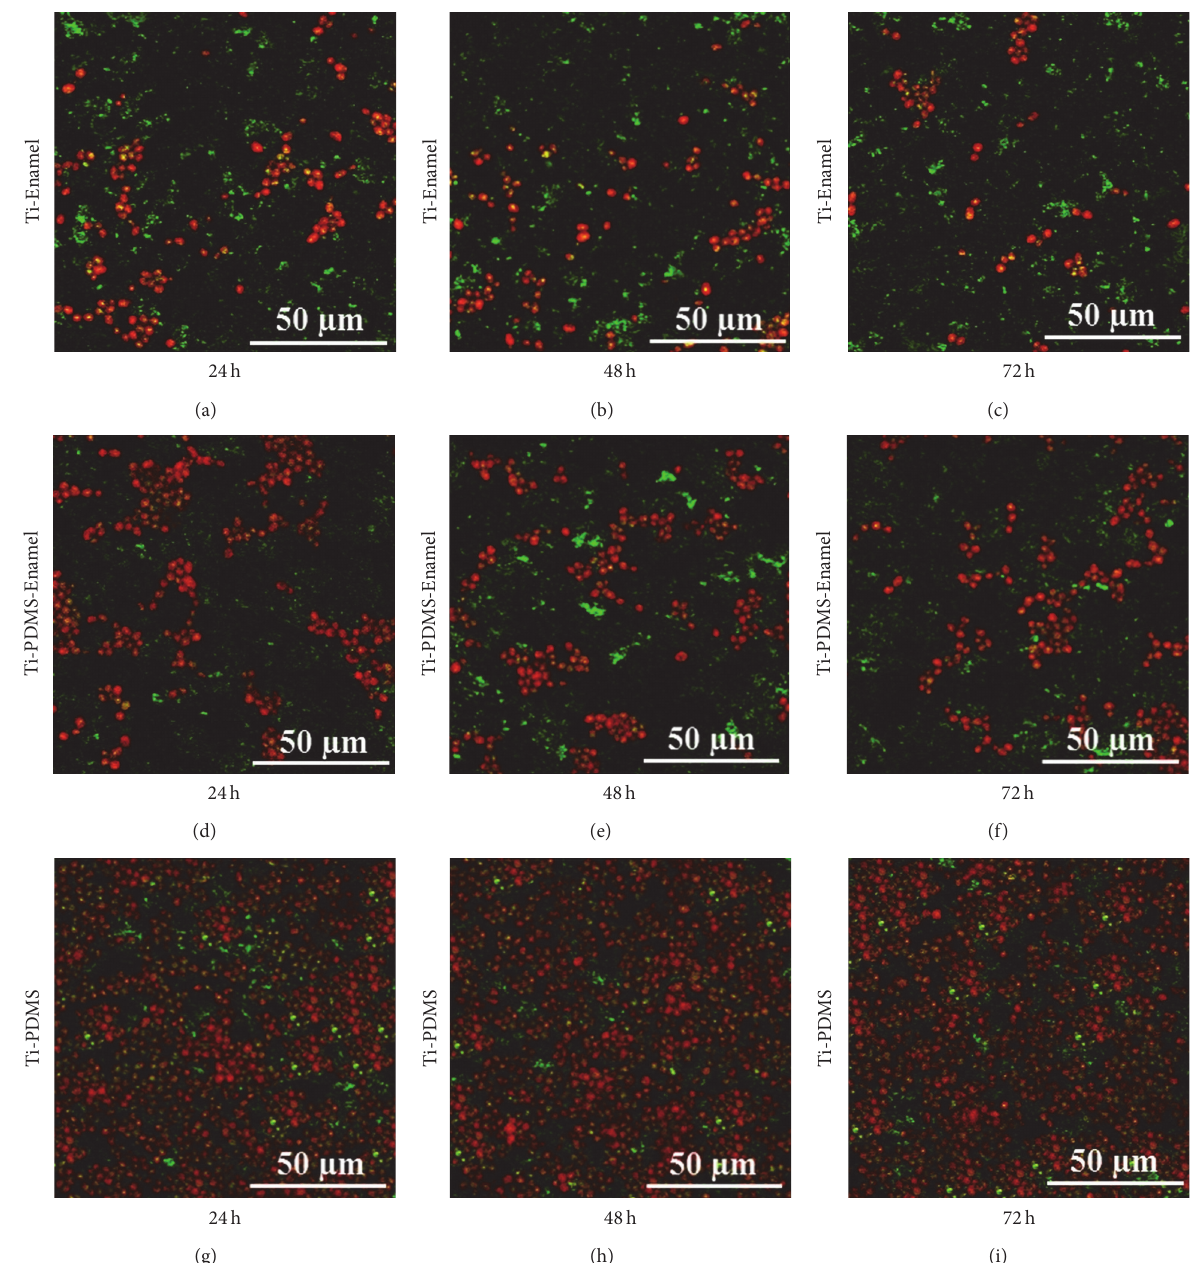
Figure 8: CLSM images of C. albicans biofilm stained with ethidium bromide (5 𝜇 g/mL) developed on different substrates at various time intervals. (a) C. albicans development on Ti-Enamel layer after 24 h; (b) C. albicans development on Ti-Enamel layer after 48h; (c) C. albicans development on Ti-Enamel composite layer after 72 h; (d) C. albicans development on Ti-PDMS-Enamel layer after 24 h; (e) C. albicans development on Ti-PDMS-Enamel layer after 48 h; (f) C. albicans development on Ti-PDMS-Enamel layer after 72 h; (g) C. albicans development on Ti-PDM layer after 24 h; (h) C. albicans development on Ti-PDMS layer after 48 h; (i) C. albicans development on Ti-PDM layer after 72